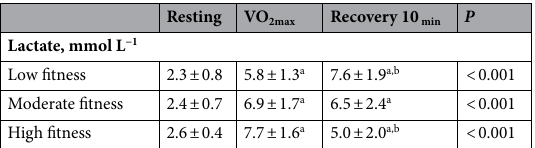
Table 5. Peripheral blood lactate obtained during the maximal cardiopulmonary test (VO 2max ) at three different moments: resting; VO 2max ; and 10 min after the start of recovery (Recovery 10 min ). Values are presented as mean ± SD. mmol L −1 millimol per liter. a P < 0.05 vs. resting. b P < 0.05 vs. VO 2max .